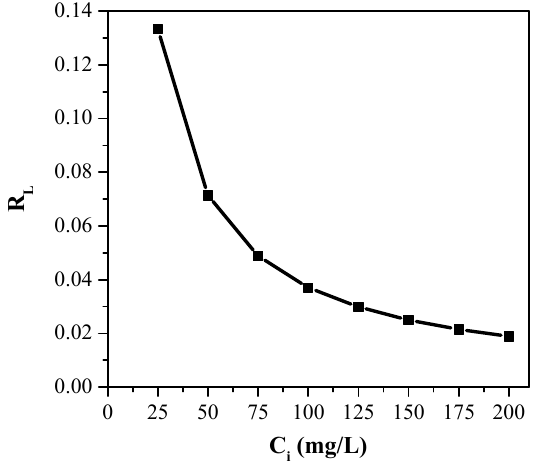
Figure 8. Graphical presentation of the separation factor (R L ) against initial dye concentration (pH: 7, C i : 25, 50, 75, 100, 150 and 200 mg/L, M ads : 0.5 g, t : 60 min, T: 25 °C, S: 180 rpm, solution volume: 250 mL).